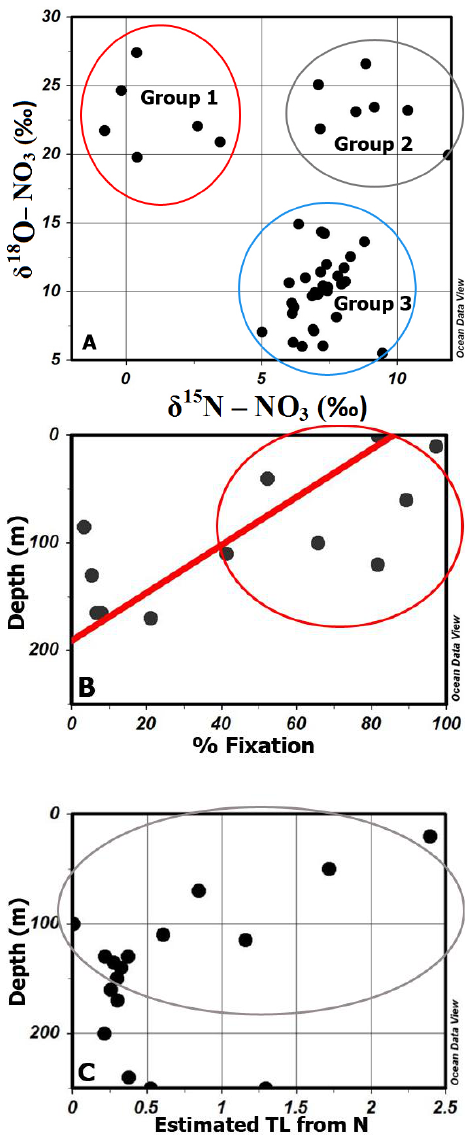
Fig. 8. Isotopic composition of dissolved nitrate across the study Figure 8 518 region. (A) δ 15 N near or below zero is classic evidence of nitro- gen fixation as an N source, while deep nitrate classically has a re- gional signature of ∼ 6.60‰. Near-surface δ 18 O sources are known to be enriched in δ 18 O due to preferential evaporation of 16 O over 18 O. Group 1: nitrate produced using fixed nitrogen and surface oxygen (red circle) Group 2: nitrate produced using surface oxygen and nitrogen from non-fixation sources, likely to be grazing (Mon- toya et al., 2002) (black circle) Nitrate produced at depth conform- ing to the regional mean of δ 15 N = 6.60‰ (Waite et al., 2007a) (blue circle). (B) Derived value for % of nitrate originating from nitrogen fixation calculated with a simple linear isotope mixing model, with a fixation end point δ 15 N =− 10‰, and deep regener- ated nitrate 15 N = 6.60‰. (C) Speculative estimation of the source trophic level (TL) of regeneration for the measured nitrate – based on the 1δ 15 N of 2.2‰ per trophic level we estimated for the olig- otrophic Indian Ocean by Waite et al. (2007a); see text for